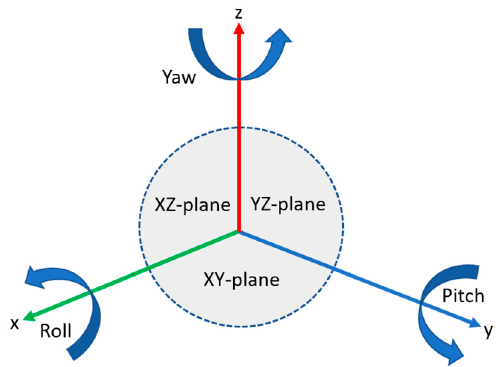
Figure 2. Diagram of the Y-up coordinate system. Table 2. Initial orientation of cameras for mono data acquisition.